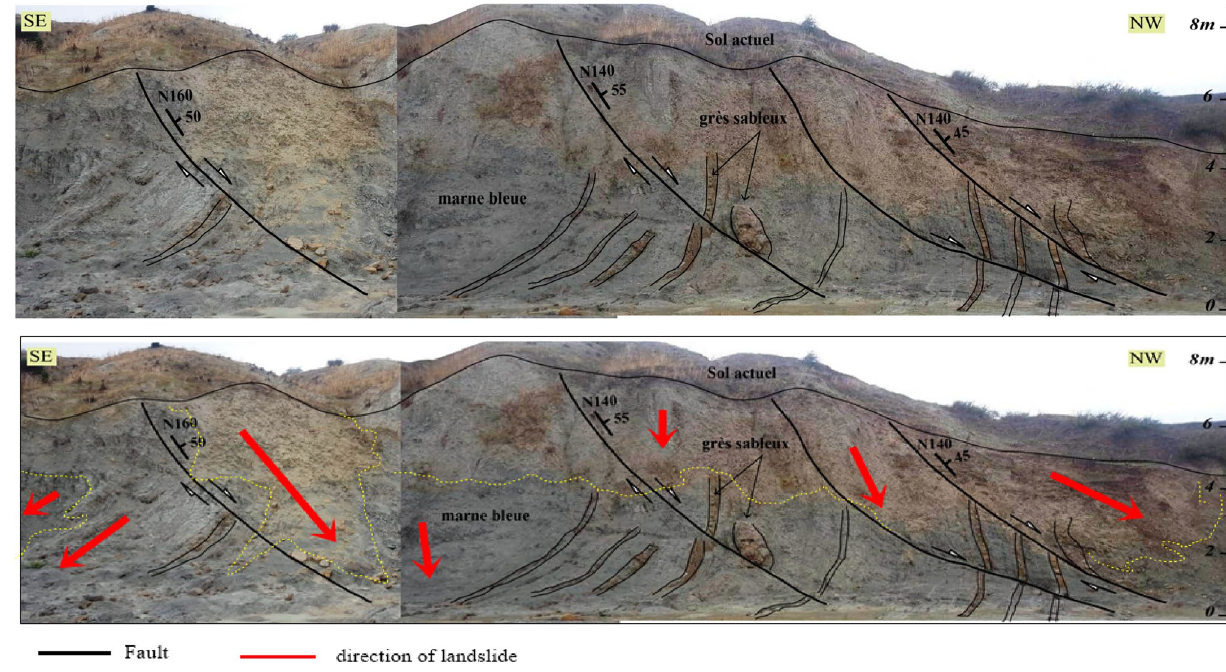
Fig. 7 Mapping a tectonic normal fault in the Chebabate area (left shore of the Inaouene